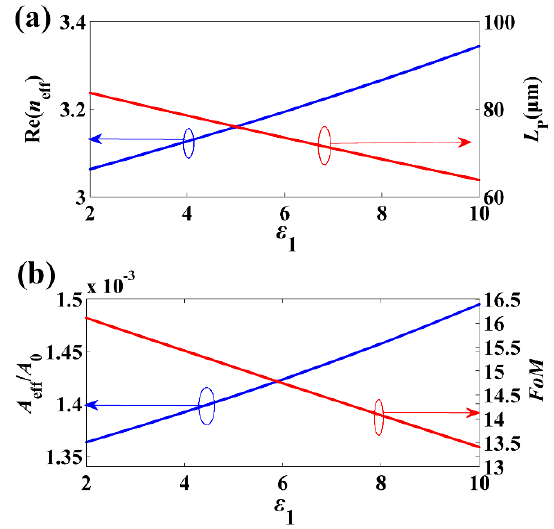
Figure 5. ( a ) Real part of n eff and L P , and ( b ) A eff/ A 0 and FoM as a function of nanowire permittivity at f 0 = 3 THz. Here u c = 0.5 eV, a = 0.5 µ m, b = 1 µ m, and ε 2 = f 0 = 3 THz. Here u c = 0.5 eV, a = 0.5 μm, b = 1 μm, and ε 2 = 1.